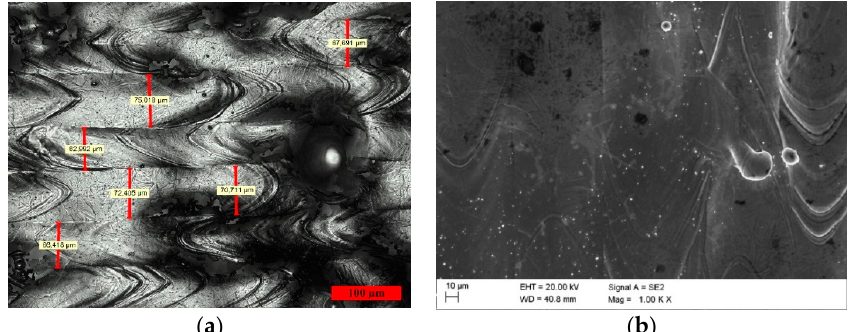
Figure 18. The surface structure of Ti6Al4V Ti solid 1 alloy specimen made ( a ) on a light microscope and ( b ) on an SEM.